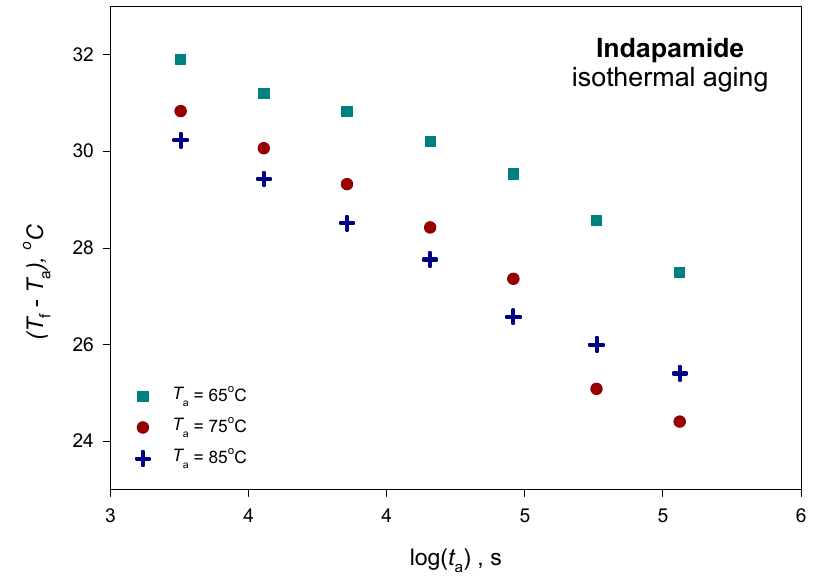
Figure 9. The changes of fictive temperature ( T f ) with annealing time ( t a ) for the studied aging temperatures ( T a ).